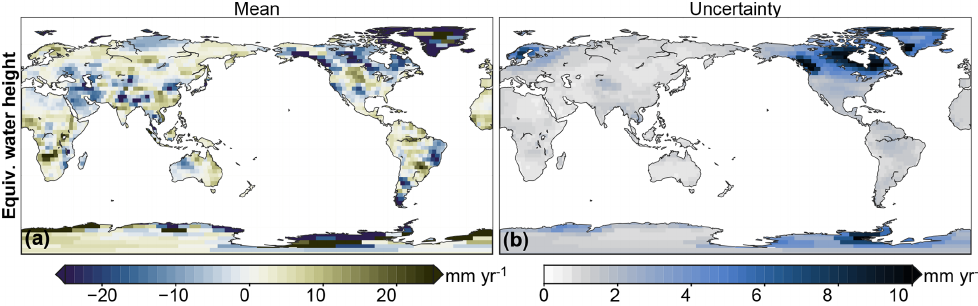
Figure 3. Trends and accompanying uncertainties in contemporary EWH changes on land over 2002–2017, observed by GRACE. These trends have been corrected for